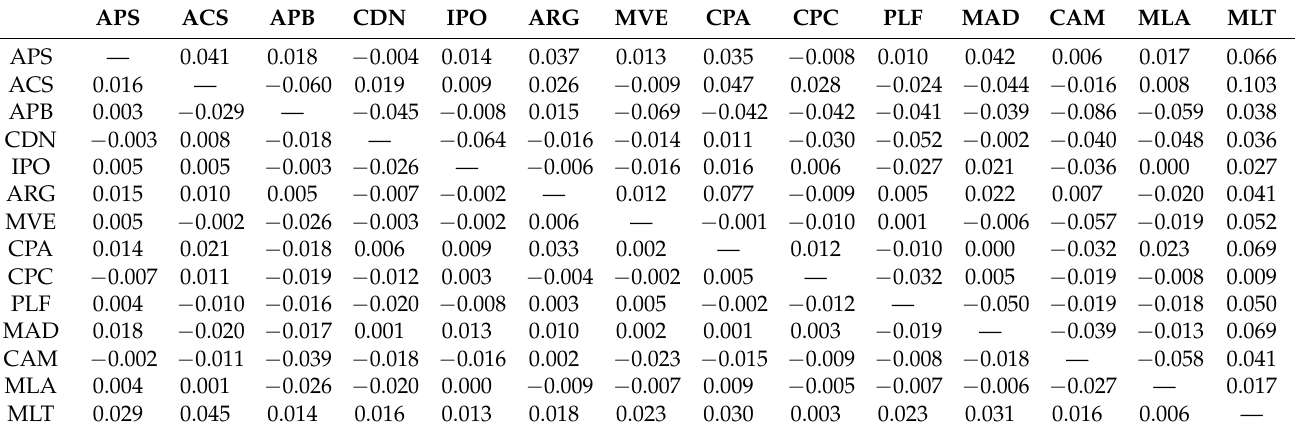
Table 3. Pairwise population differentiation. Weir and Cockerham’s θ and Hedrick’s G ’ ST values are reported below and above the diagonal, respectively. Values outlined in bold indicate population pairs showing significant genetic divergence based on Fisher’s exact test for genetic homogeneity of genotype frequencies. Due to multiple testing, probability values were adjusted following Narum [56]. Populations are abbreviated as in Figure